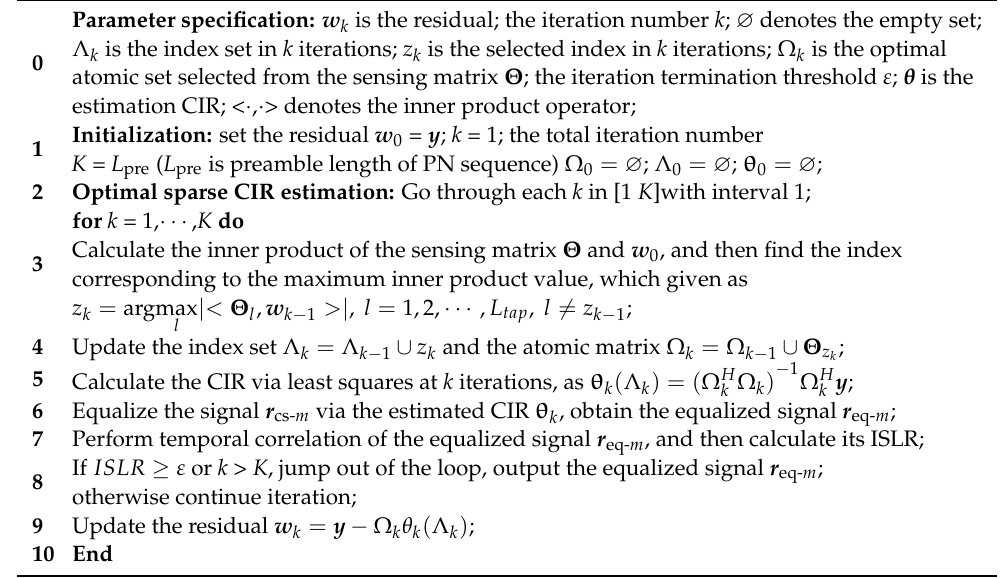
Algorithm 1. Summarize: The main procedures of the TC-AOMP